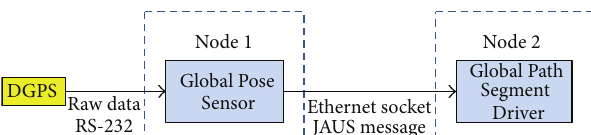
Figure 6: JAUS message header [21].